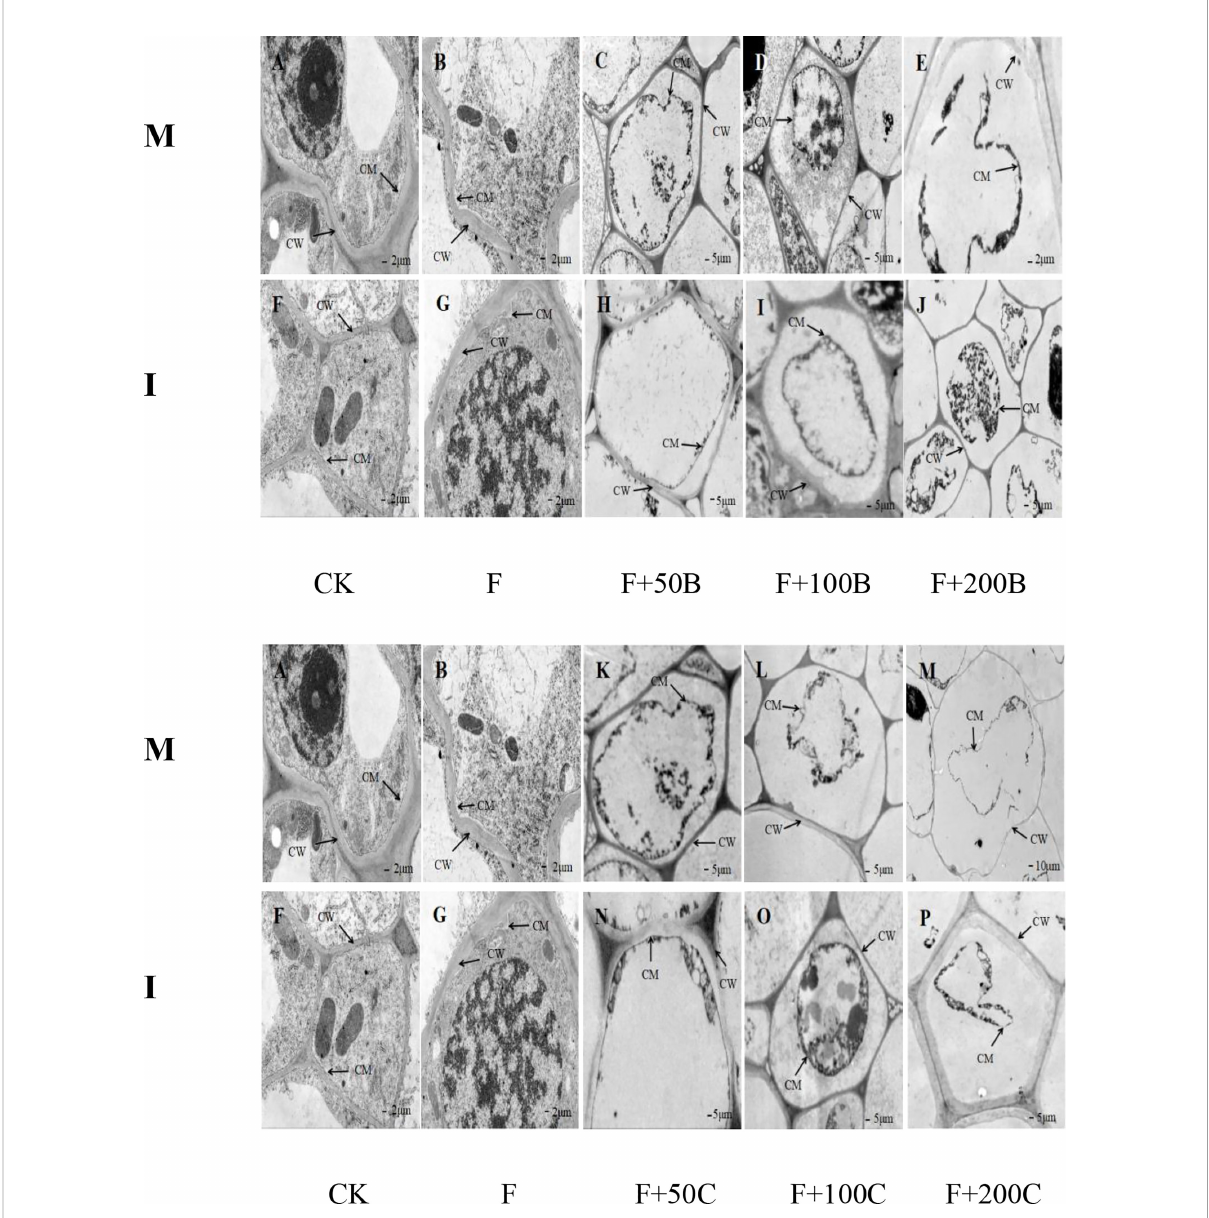
FIGURE 5 Effects of different concentrations of benzoic acid on ultrastructure in a root of faba bean ( Vicia faba ) inoculated with F under different cropping modes. Effects of different concentrations of cinnamic acid on ultrastructure in a root of faba bean ( Vicia faba ) inoculated with F under different cropping modes. M, faba bean monocropping; I, wheat – faba bean intercropping; CW, cell wall; CM, cell membrane; F, Fusarium oxysporum f. sp. fabae. (A) Monocropping faba bean under CK treatment. (B) Monocropping faba bean under inoculation FOF. (C) Monocropping faba bean under inoculated FOF and exogenous application of 50 mg·L − 1 of benzoic acid. (D) Monocropping faba bean under inoculated FOF and exogenous application of 100 mg·L − 1 of benzoic acid. (E) Monocropping faba bean under inoculated FOF and exogenous application of 20 mg·L − 1 of benzoic acid. (F) Intercropping faba bean under CK treatment. (G) Intercropping faba bean under inoculation FOF. (H) Intercropping faba bean under inoculated FOF and exogenous application of 50 mg·L − 1 of benzoic acid. (I) Intercropping faba bean under inoculated FOF and exogenous application of 100 mg·L − 1 of benzoic acid. (J) Intercropping faba bean under inoculated FOF and exogenous application of 200 mg·L − 1 of benzoic acid. (K) Monocropping faba bean under inoculated FOF and exogenous application of 50 mg·L − 1 of cinnamic acid. (L) Monocropping faba bean under inoculated FOF and exogenous application of 100 mg·L − 1 of cinnamic acid. (M) Monocropping faba bean under inoculated FOF and exogenous application of 200 mg·L − 1 of cinnamic acid. (N) Intercropping f faba bean under inoculated FOF and exogenous application of 50 mg·L − 1 of cinnamic acid. (O) Intercropping faba bean under inoculated FOF and exogenous application of 100 mg·L − 1 of cinnamic acid. (P) Intercropping faba bean under inoculated FOF and exogenous application of 200 mg·L − 1 of cinnamic